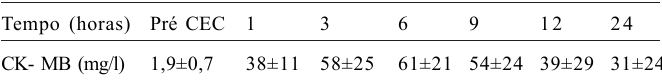
Tabela 3. Valores plasmáticos da enzima CKMB (Média ± Desvio padrão).